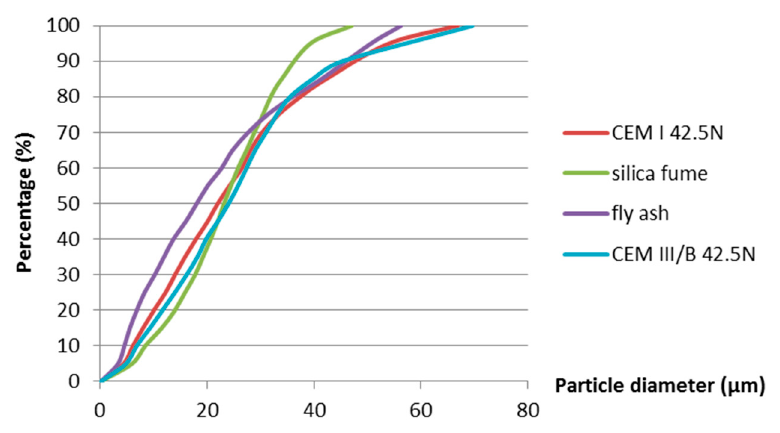
Figure 1. Particle size distribution of materials powders.